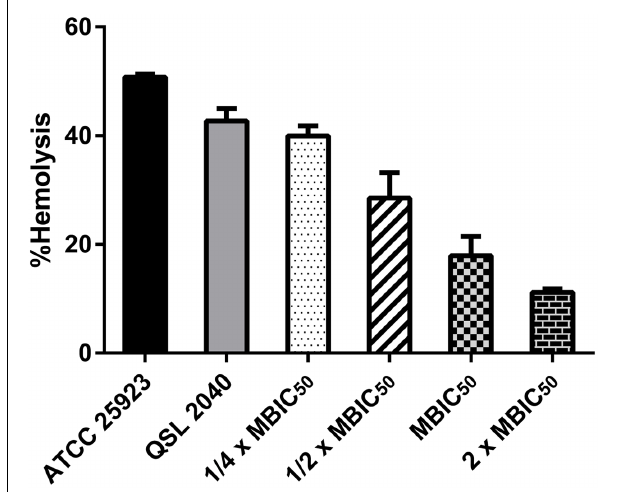
FIGURE 2 | Effect of ADM 3 on hemolysin production in S. aureus (ATCC 25923—reference strain; QSL2040—clinical isolate). The concentrations used were 1 / 4 × MBIC 50 (1.25 µ g/mL), 1 / 2 × MBIC 50 (2.5 µ g/mL), MBIC 50 (5 µ g/mL), and 2 × MBIC 50 (10 µ